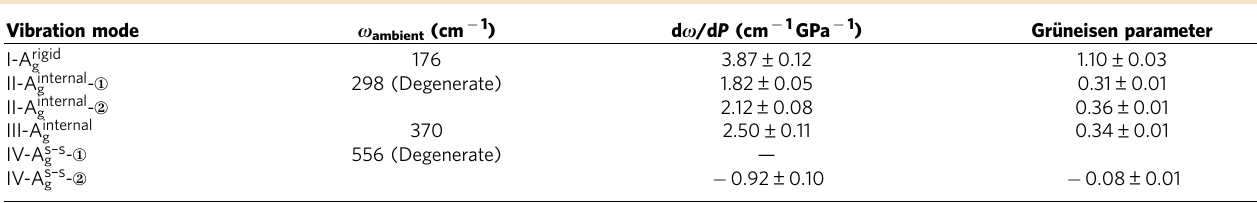
Table 1 | Quantitative analysis of vibration properties of TiS 3